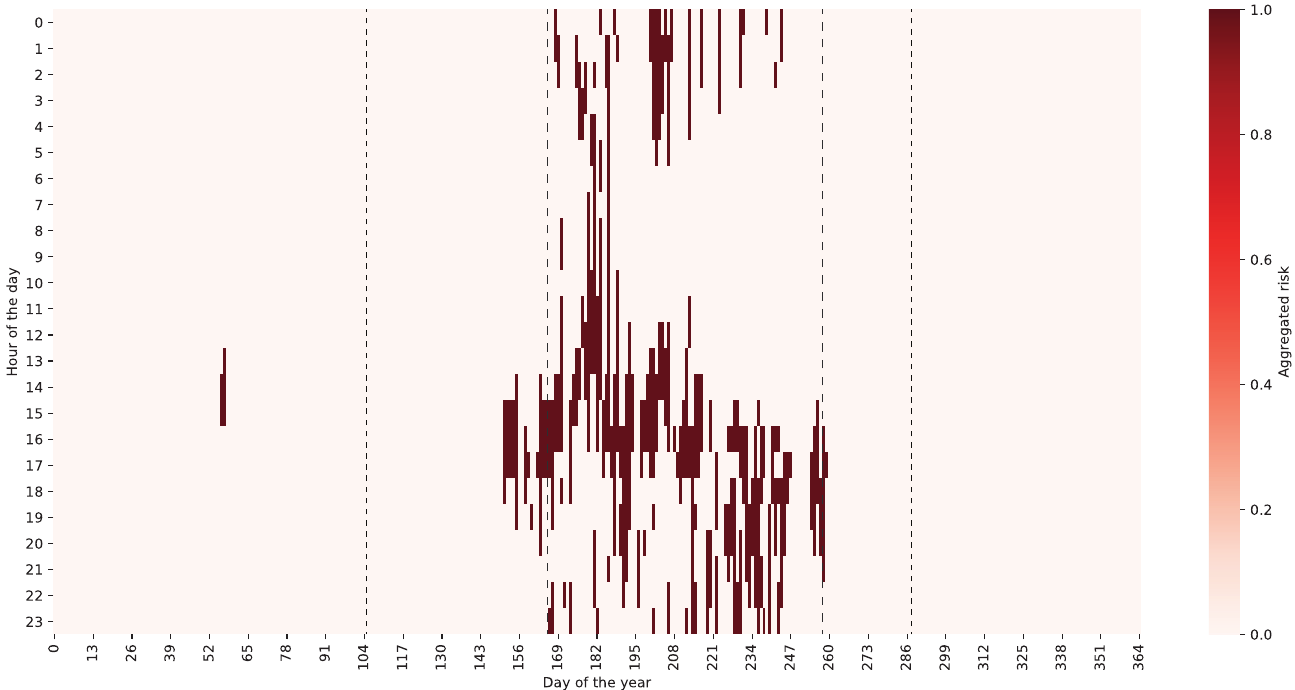
Figure 6. Conjoint risk frequency distribution on a yearly basis for 2019’s data extracted from weather and air quality station Milano v. Juvara.